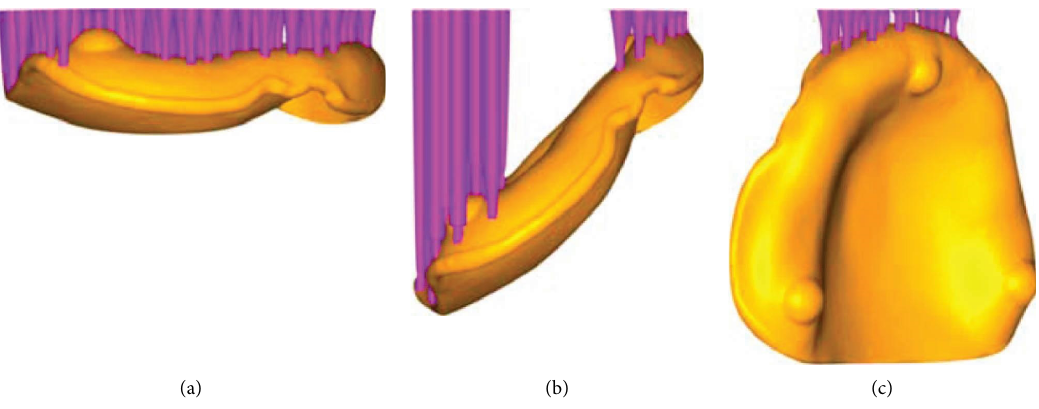
Figure 2: Tree diferent build angles used in this study. (a) 0 ° . (b) 45 ° . (c) 90 °